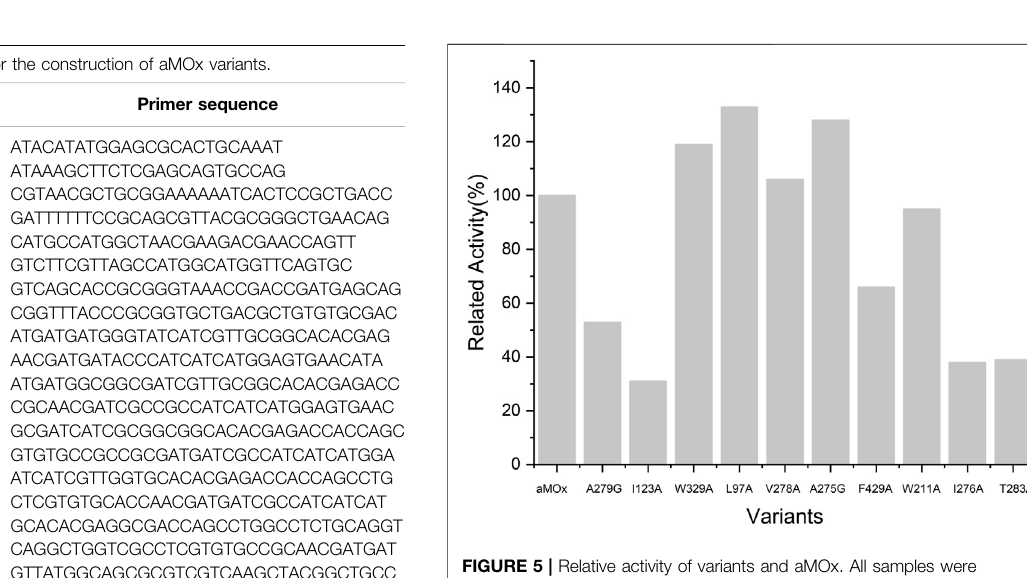
FIGURE 5 | Relative activity of variants and aMOx. All samples were performed at least twice.